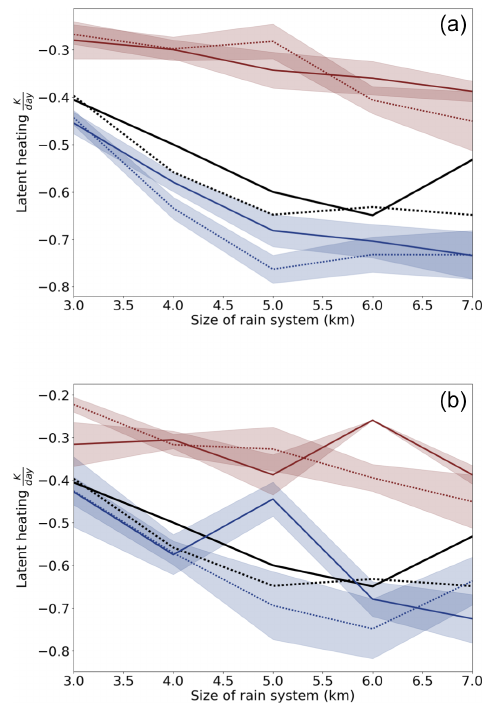
Figure A3. Figure 4 with ± standard error shaded.